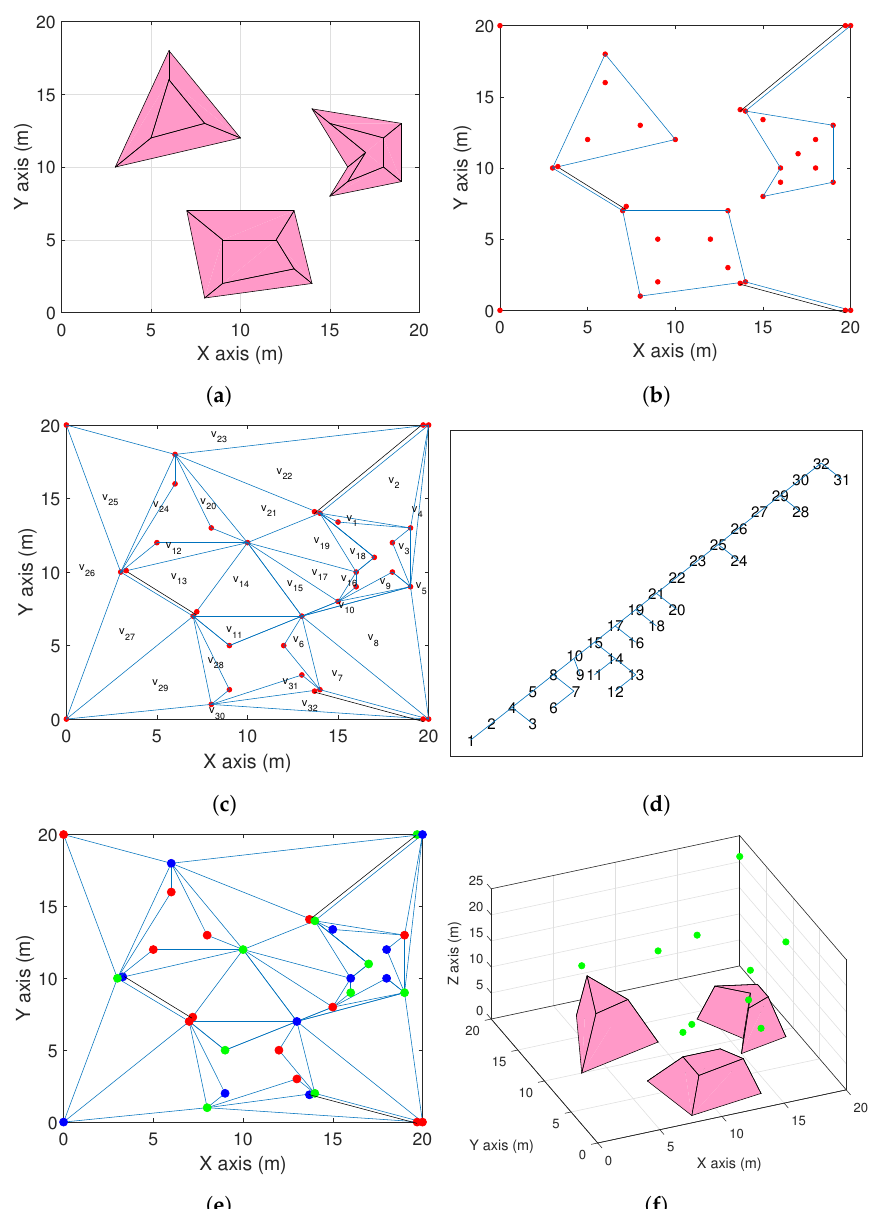
Figure 6. ( a ) A square area with 3 very uneven areas. ( b ) The construction of polygon Q . ( c ) The construction of triangulation ˆ T . ( d ) The dual graph of ˆ T with the vertices numbered from 1 to 32. ( e ) Painting the vertices. ( f ) Deployment of aerial drones in 3D